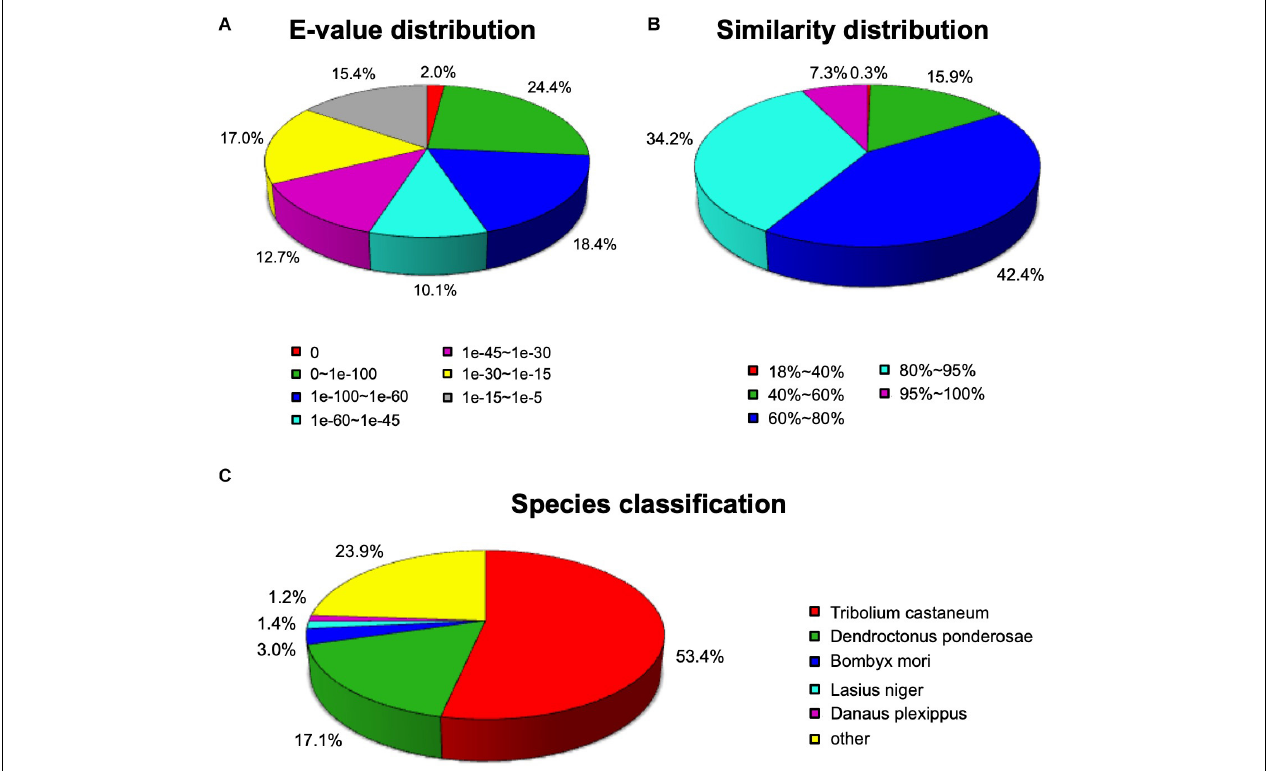
FIGURE 1 | Homology analysis of Apriona germari unigenes. (A) E-value distribution. (B) Similarity distribution. (C) Species distribution. All unigenes that had BLASTX annotations within the NCBI nr database with a cutoff E -value of 10 − 5 were analyzed. The first hit of each sequence was used for